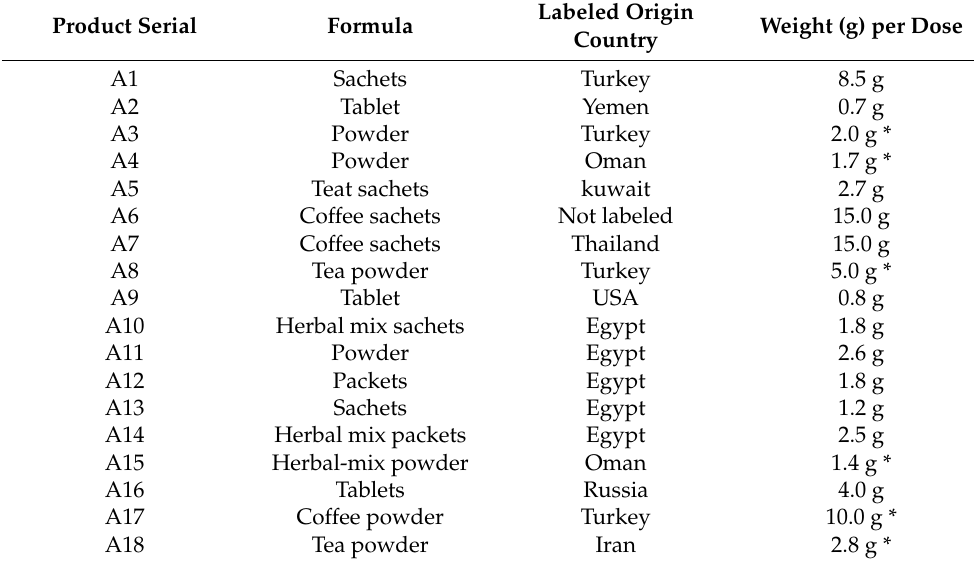
Table 1. List of weight loss products under